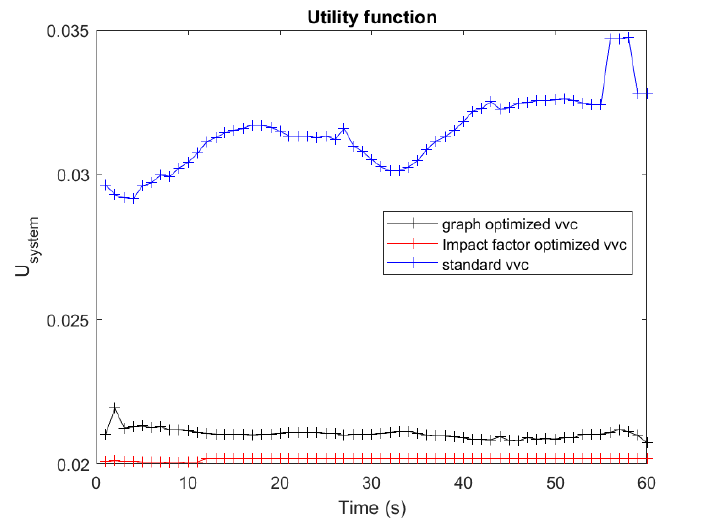
Figure 10. Comparison of utility across the optimized one minute time frame.